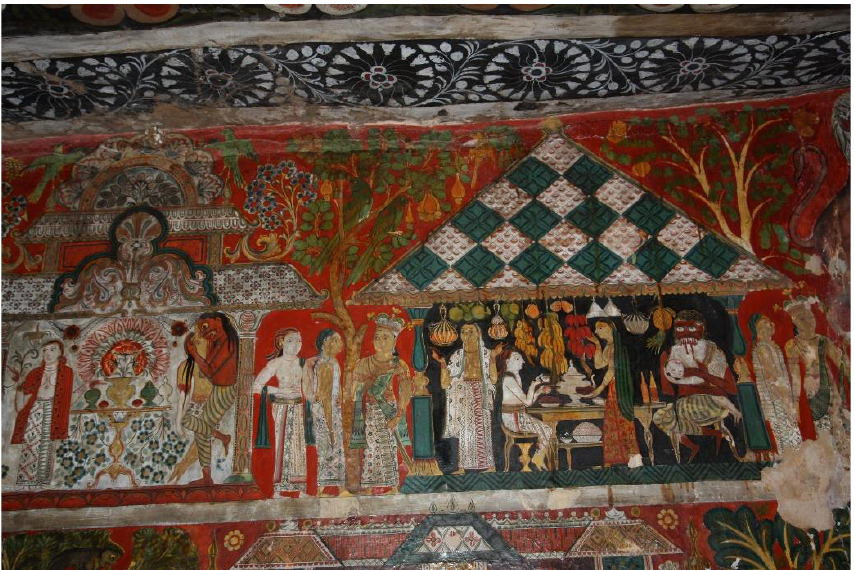
Figure 5. The temptation of taste from the Telapatta Jātaka, Mulkirgala, Sri Lanka, Courtesy Osmund Bopearachchi.